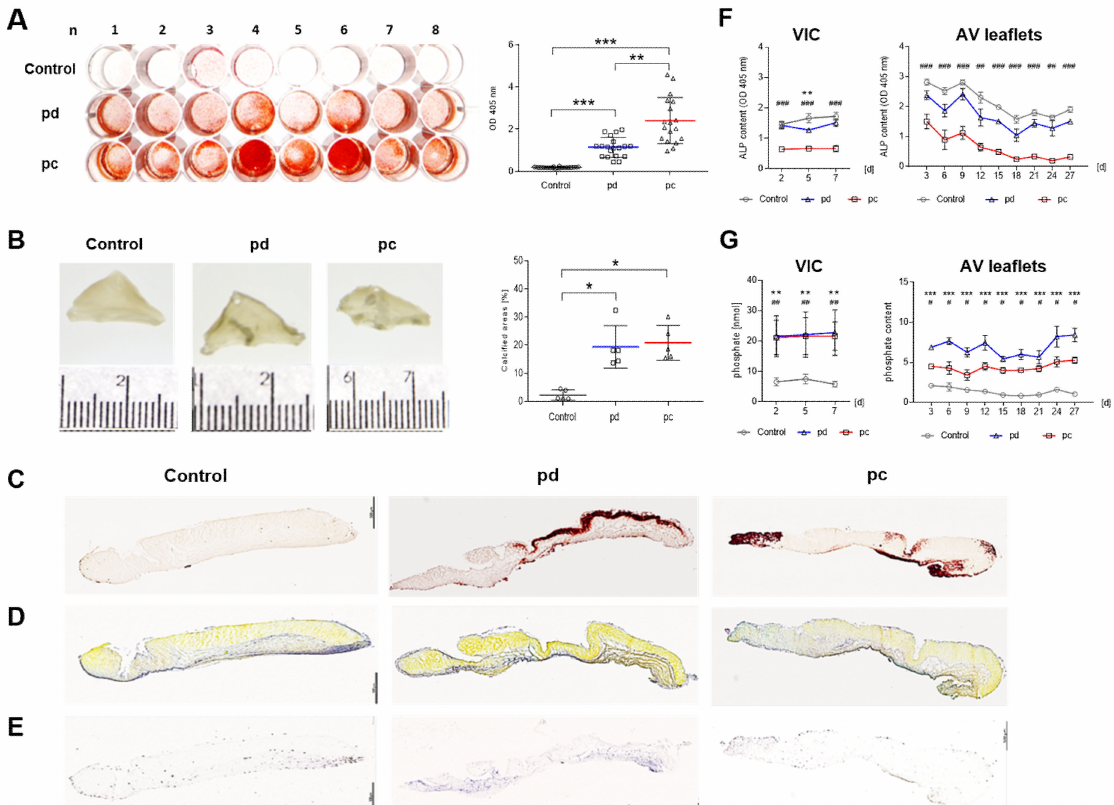
Figure 6. Comparison of pro-degenerative and pro-calcifying conditions. ( A ) Alizarin red S staining and quantification of 2D VIC cultures ( n = 16) after 7 d under pro-degenerative (pd, β -GP + CaCl2; blue line) and pro-calcifying (pc, NaH 2 PO 4 , red line) conditions compared to control conditions. ( B ) Images and transmitted light images of AV leaflets after 28 d cultivation under pd and pc conditions and analysis of optical density (OD). Data ( n = 6) are mean ± SEM. Alizarin red S ( C ), Movat’s pentachrome ( D ), and AP staining ( E , purple areas) of AV leaflets under pd, pc, and control conditions after 28 d cultivation. Scale bar indicates 100 µ m. Representative images of five different experiments are shown. Analysis of AP ( F ) and phosphate ( G ) in supernatants of 2D VIC cultures (d2–d7) and AV leaflet cultures (d3–d27) under pd (blue line) and pc (red line) conditions compared to control conditions (gray line). Data ( n = 5) are mean ± SEM. p -values (*: pd vs. control, #: pc vs. control) are calculated by using Kruskal–Wallis test with Dunn’s multiple comparison post hoc test. * and #: p < 0.05; ** and ##: p < 0.01; *** and ###: p <